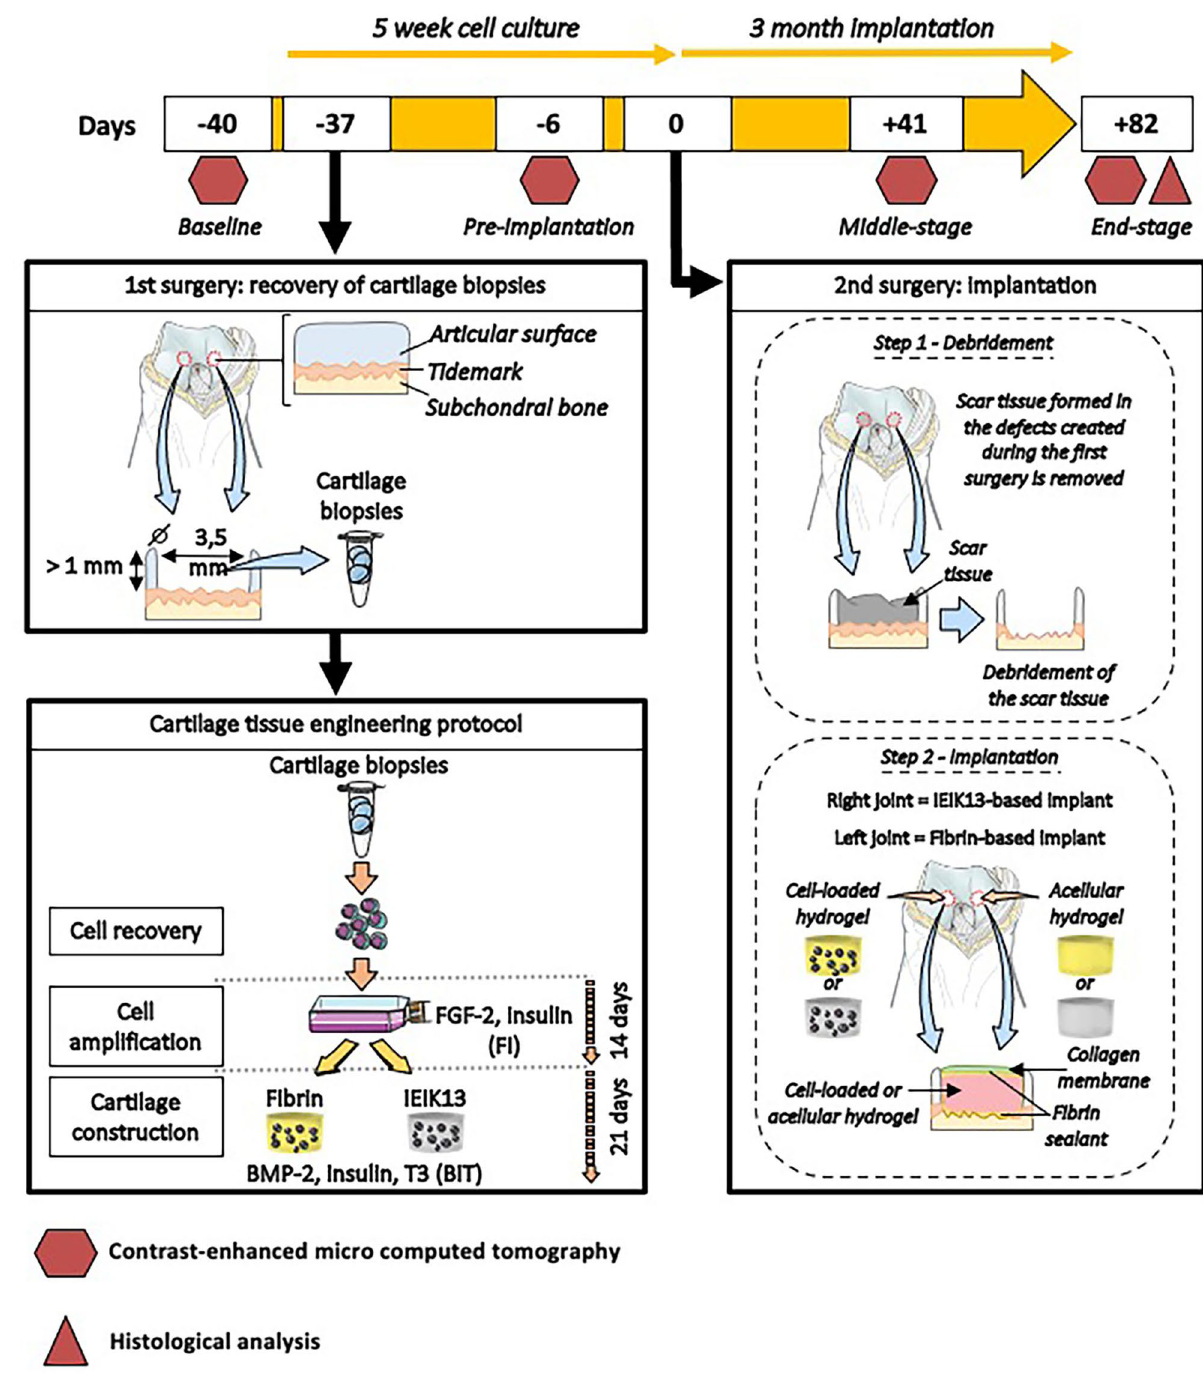
Figure 8. Experimental design of the animal study showing the preparation process of the cartilage constructs made of IEIK13 or fibrin gel combined to chondrocytes. The key times of the study are referred as numbers of days before or after the day of implantation (day 0). Right knee—IEIK13